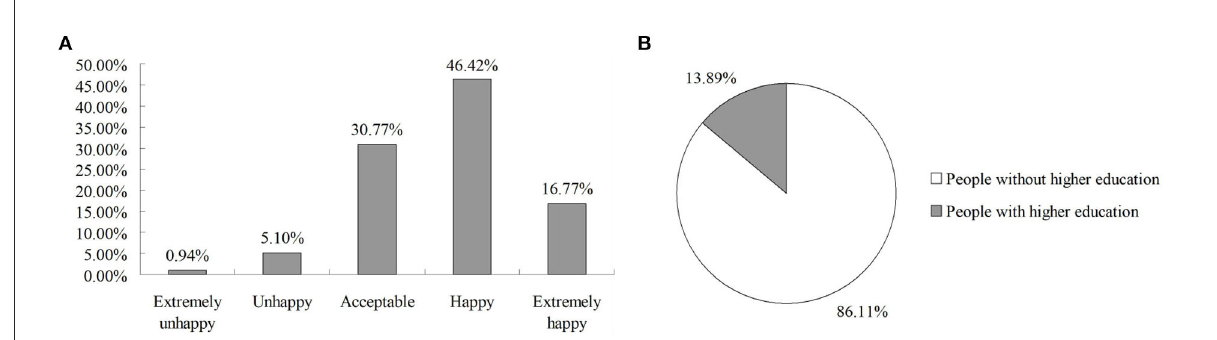
FIGURE1 Preliminary statistics. (1) Data source : 2011, 2013, 2015, and 2017 waves of CHFS. (2) The self-reported happiness with current life is measured on a five-point scale, ranging from “extremely unhappy” to “extremely happy.” (3) The higher education in this study is defined as an indicator variable, and people with higher education means they have got bachelor degree, master degree, or Ph.D degree when the survey was conducted. (A) frequency distribution of happiness. (B) percentage of higher educated